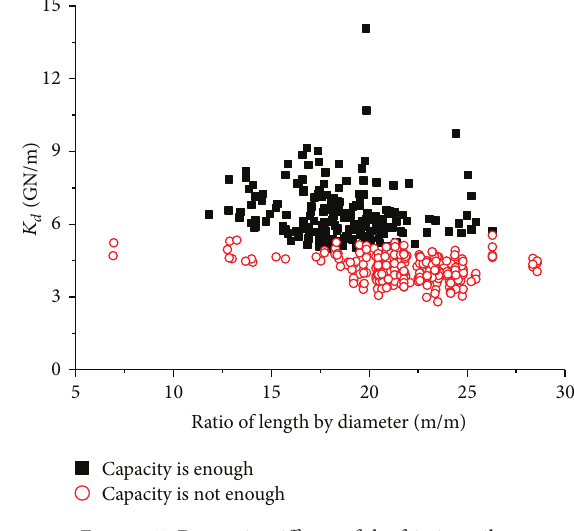
Figure 11: Dynamic stiffness of the friction piles.